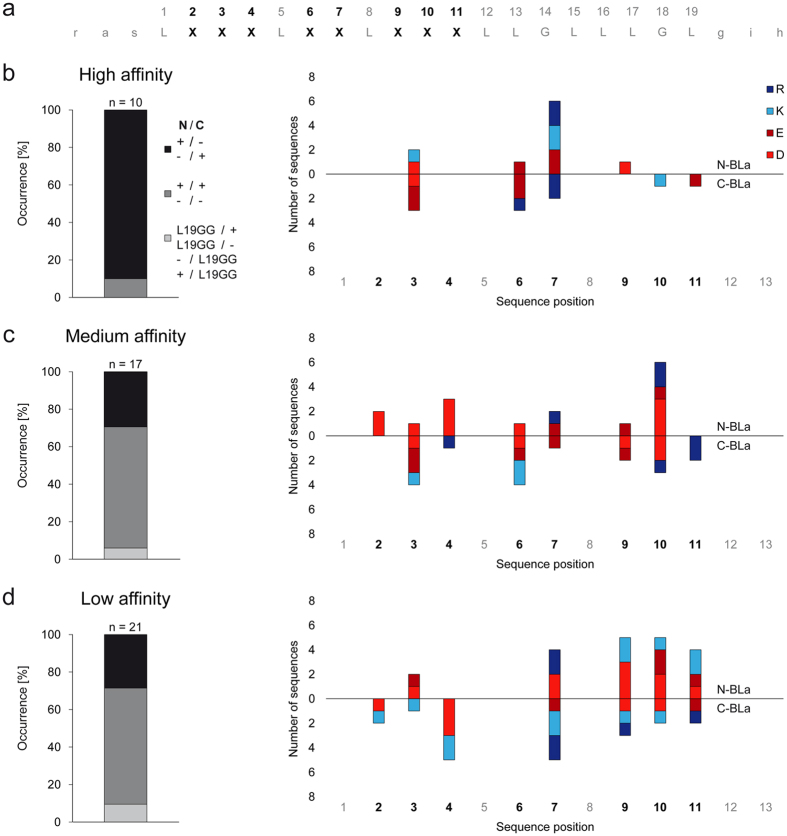
Design of combinatorial library and analysis of TMD pairs.(a) Pattern of randomized positions within the L19GG background. Each sequence contains a single Glu, Asp, Lys, or Arg at one of the positions X. Flanking sequences (lower case) represent the NheI/BamHI restriction sites. (b–d) An evaluation of the TMD pairs that were isolated by growth on ampicillin and sorted into high, medium and low affinity based on their individually measured LD50 values (Fig. 3). Left panels: Occurrence of pairs with oppositely charged (+/−, −/+; black bars) or like charged (+/+, −/−; grey bars) residues as well as pairs where only one TMD contained an ionizable residue (light grey). Right panels: Distribution of ionizable residues along the isolated TMD sequences encoded by N-BLa (upward pointing bars) or C-BLa (downward pointing bars) plasmids. Note that high-affinity TMD pairs tend to have oppositely charged residues mainly at positions 3, 6, and 7 and that positively and negatively charged amino acids are found in TMDs encoded by N-BLa as well as by C-BLa plasmids.